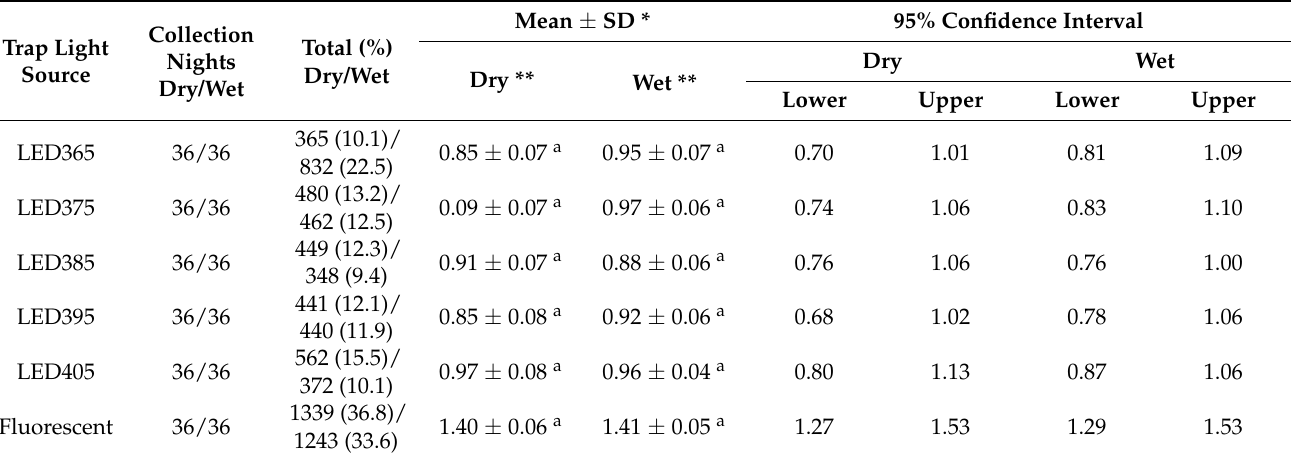
Table 2. Mean number of mosquitoes obtained from 6 light sources over 6 replications (6 nights/ replication) at Kasetsart University, Bangkok between dry and wet